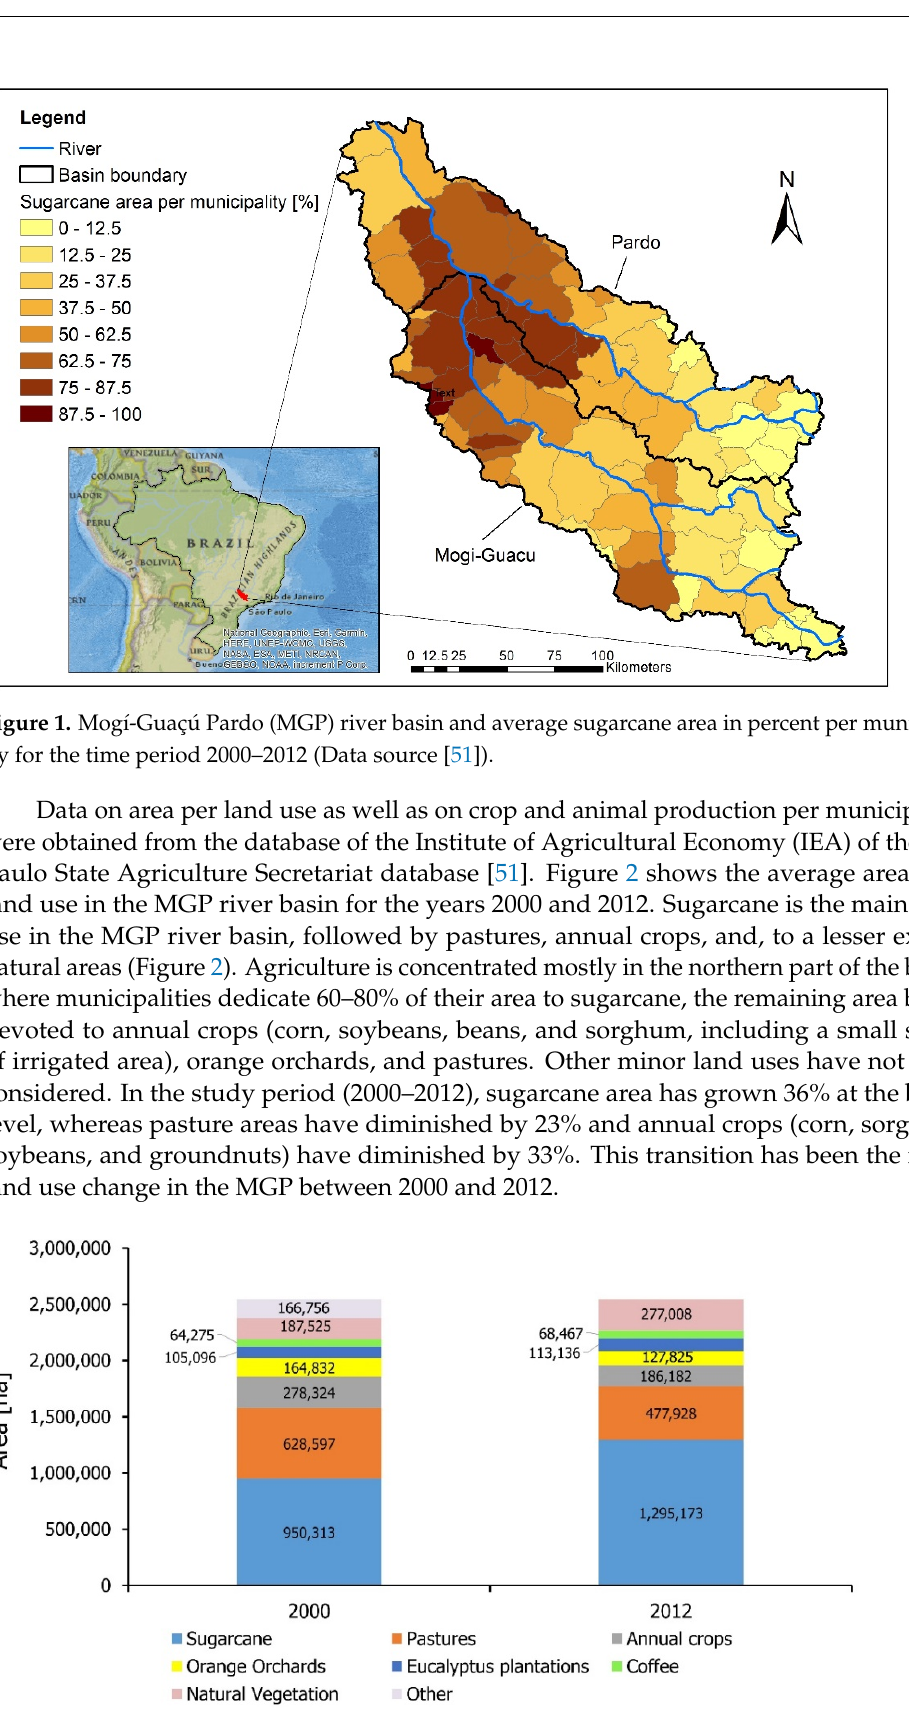
Figure 2. Main cultivated areas per land-use type for the years 2000 and 2012 in the MGP river basin (Data source [51]). Other minor land uses in the area not considered.